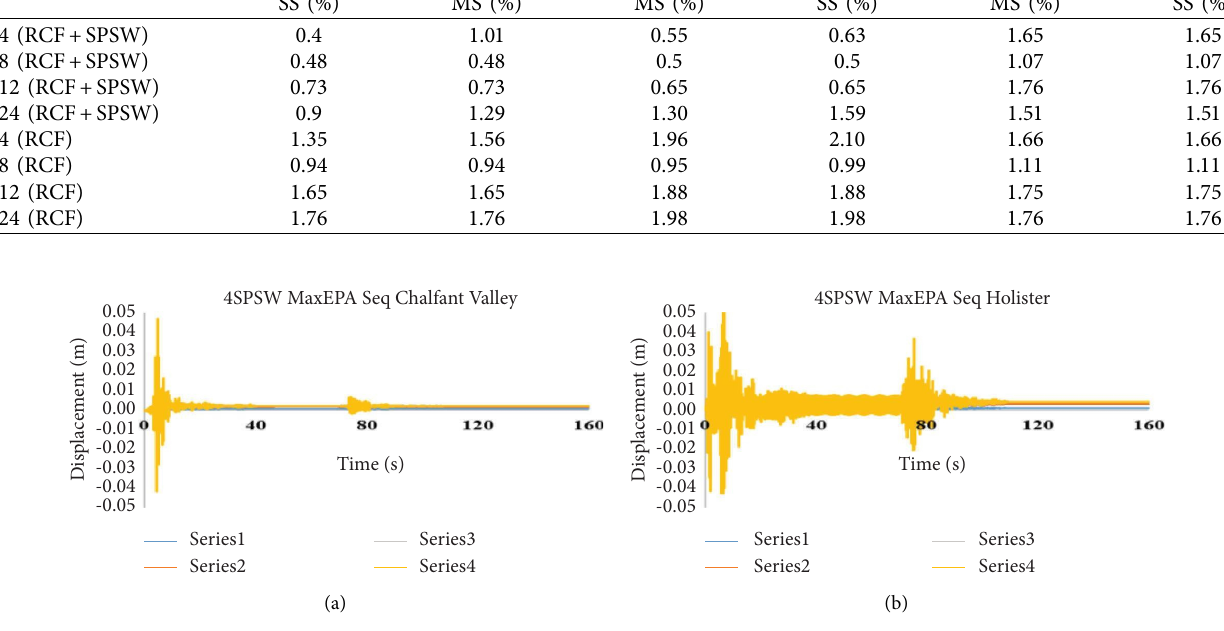
Figure 10: Time history response of 4-story model (RC +SPSW) under SS: (a) Chalfant Valley. (b) Hollister.